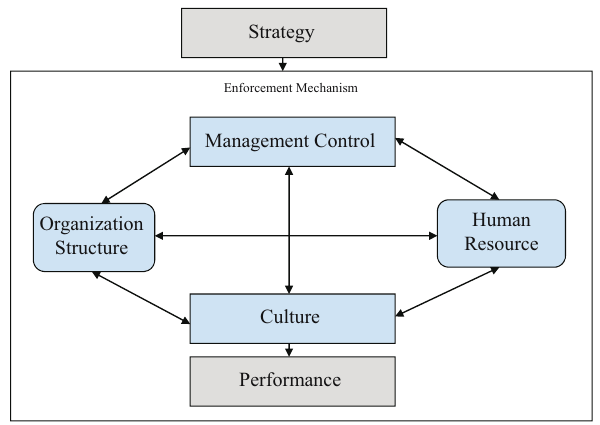
Figure 3: Management control